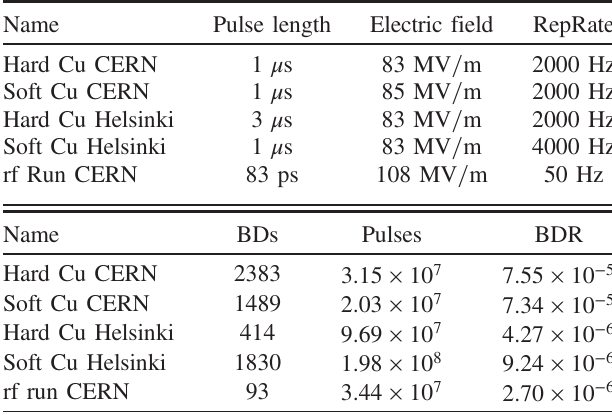
TABLE I. The four dc data sets and one rf run used for comparing the statistics on pulses between breakdowns.